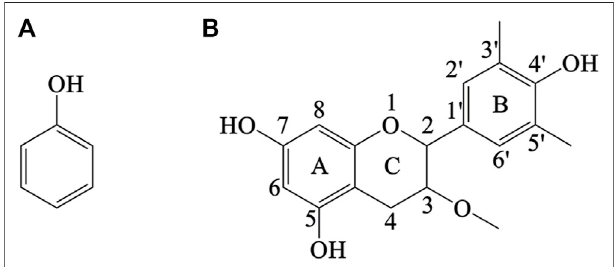
FIGURE 2 | Structure of non- fl avinoid (A) and fl avinoid (B)